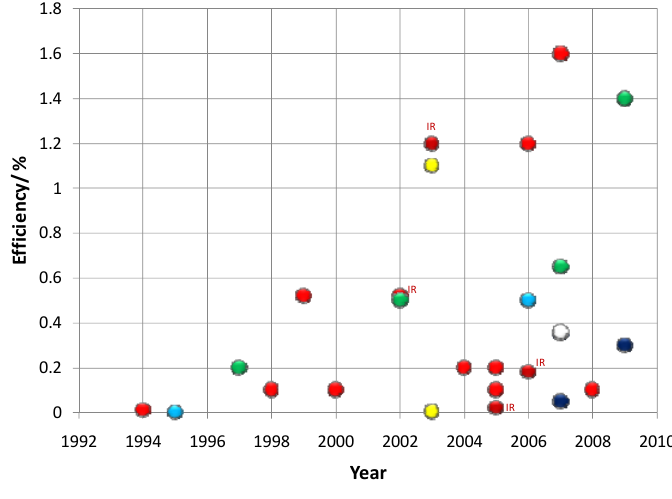
Figure 27. Efficiency of Qdot-based light emitting diode (QLED) vs. year reported in the literature; Colors of the legends represent the emitted color from the QLED (red: 601–700 nm; yellow: 561–600; green: 531–560 nm; sky blue: 491–530 nm; blue: 440–490 nm; IR: infrared emitting QLEDs are marked with IR; white: white emitting